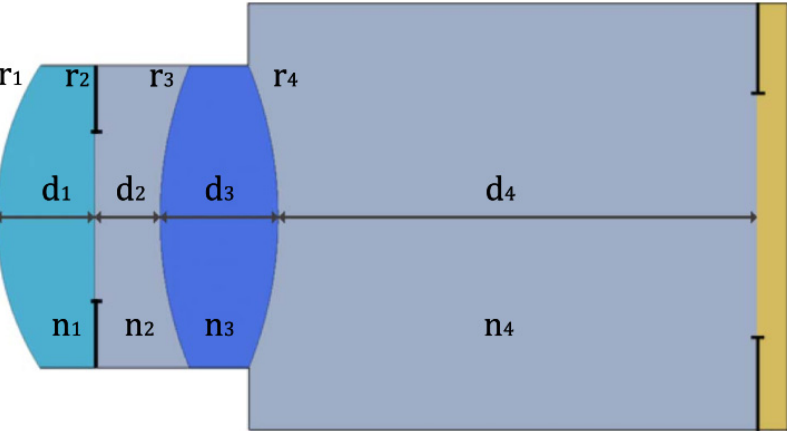
Figure 22. Schematic layout of the eye model presented by Coughlan (2017), where symbols denote the properties of the different components of the model. A separate table matches each symbol with the respective value. Applied Optics. 2017, 56, 4338–4346 ([64]). Originally published by and reprinted with permission from Optica Publishing Group.